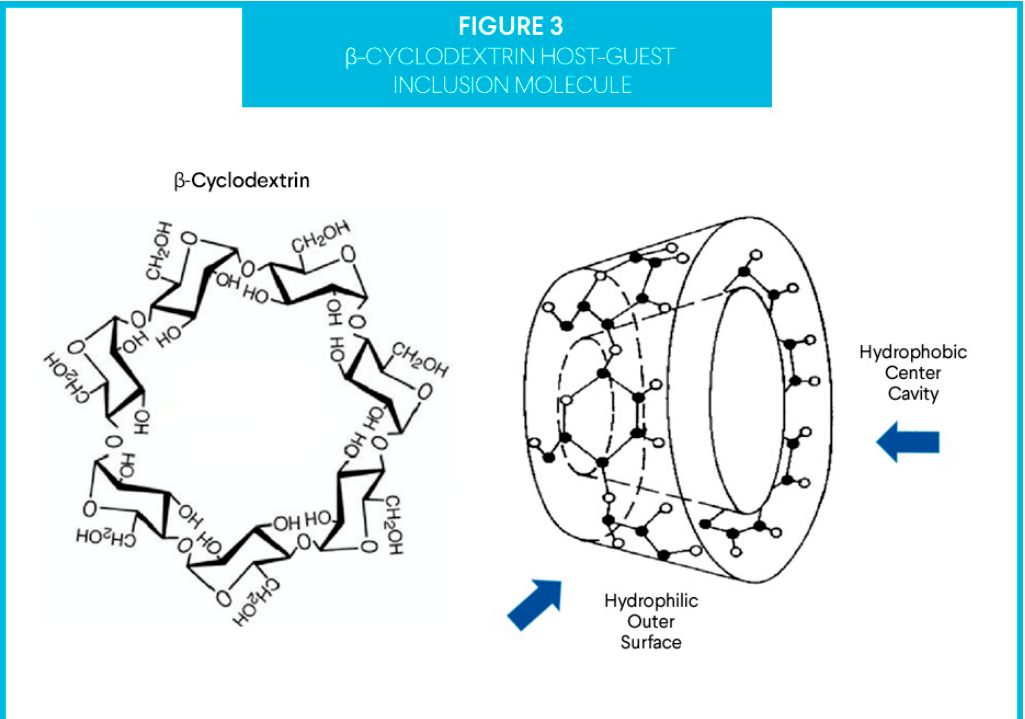
Figure 3. β -cyclodextrin molecule.